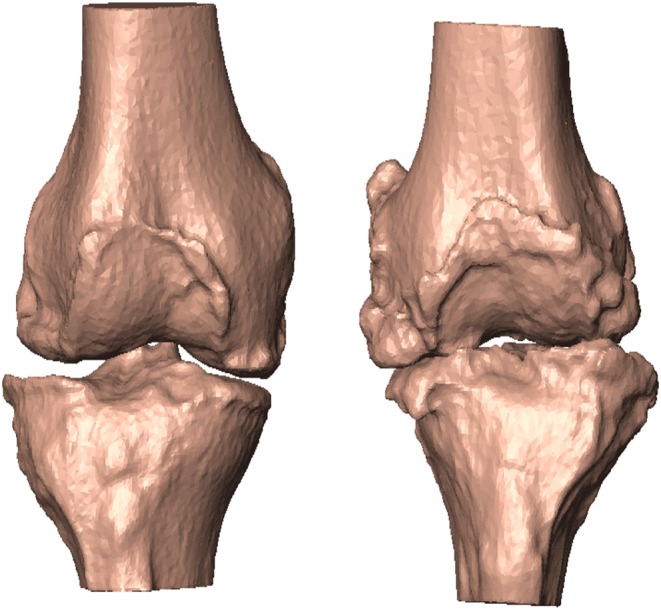
According to the five angular quantities, patient #20 featured no alignment deformation (left). Patient #29, in contrast, featured mechanical instability in all but one (IER) angular quantities (right).